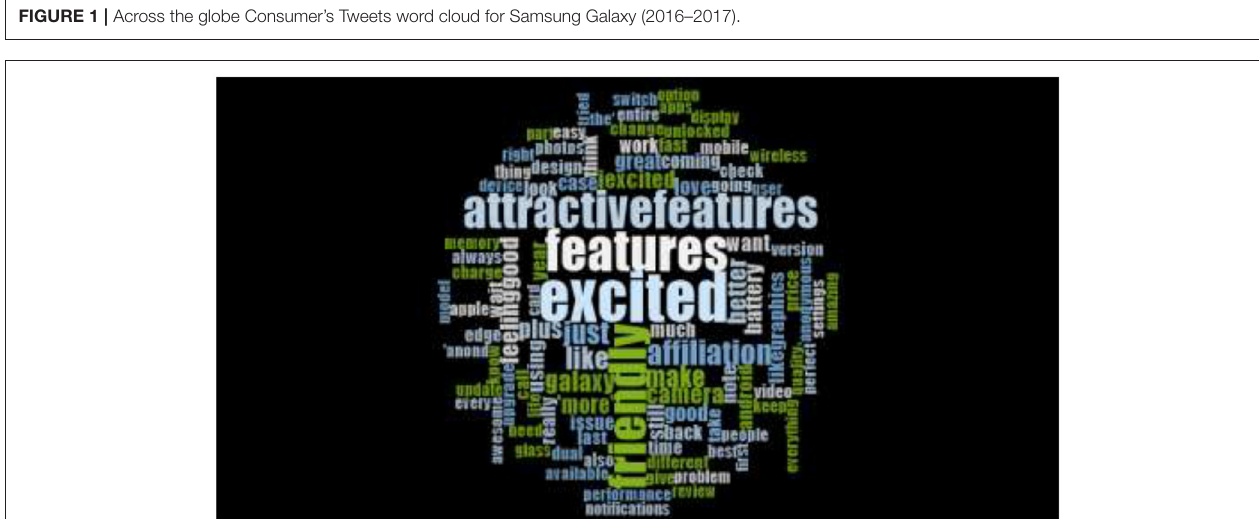
FIGURE 1 | Across the globe Consumer’s Tweets word cloud for Samsung Galaxy (2016–2017).